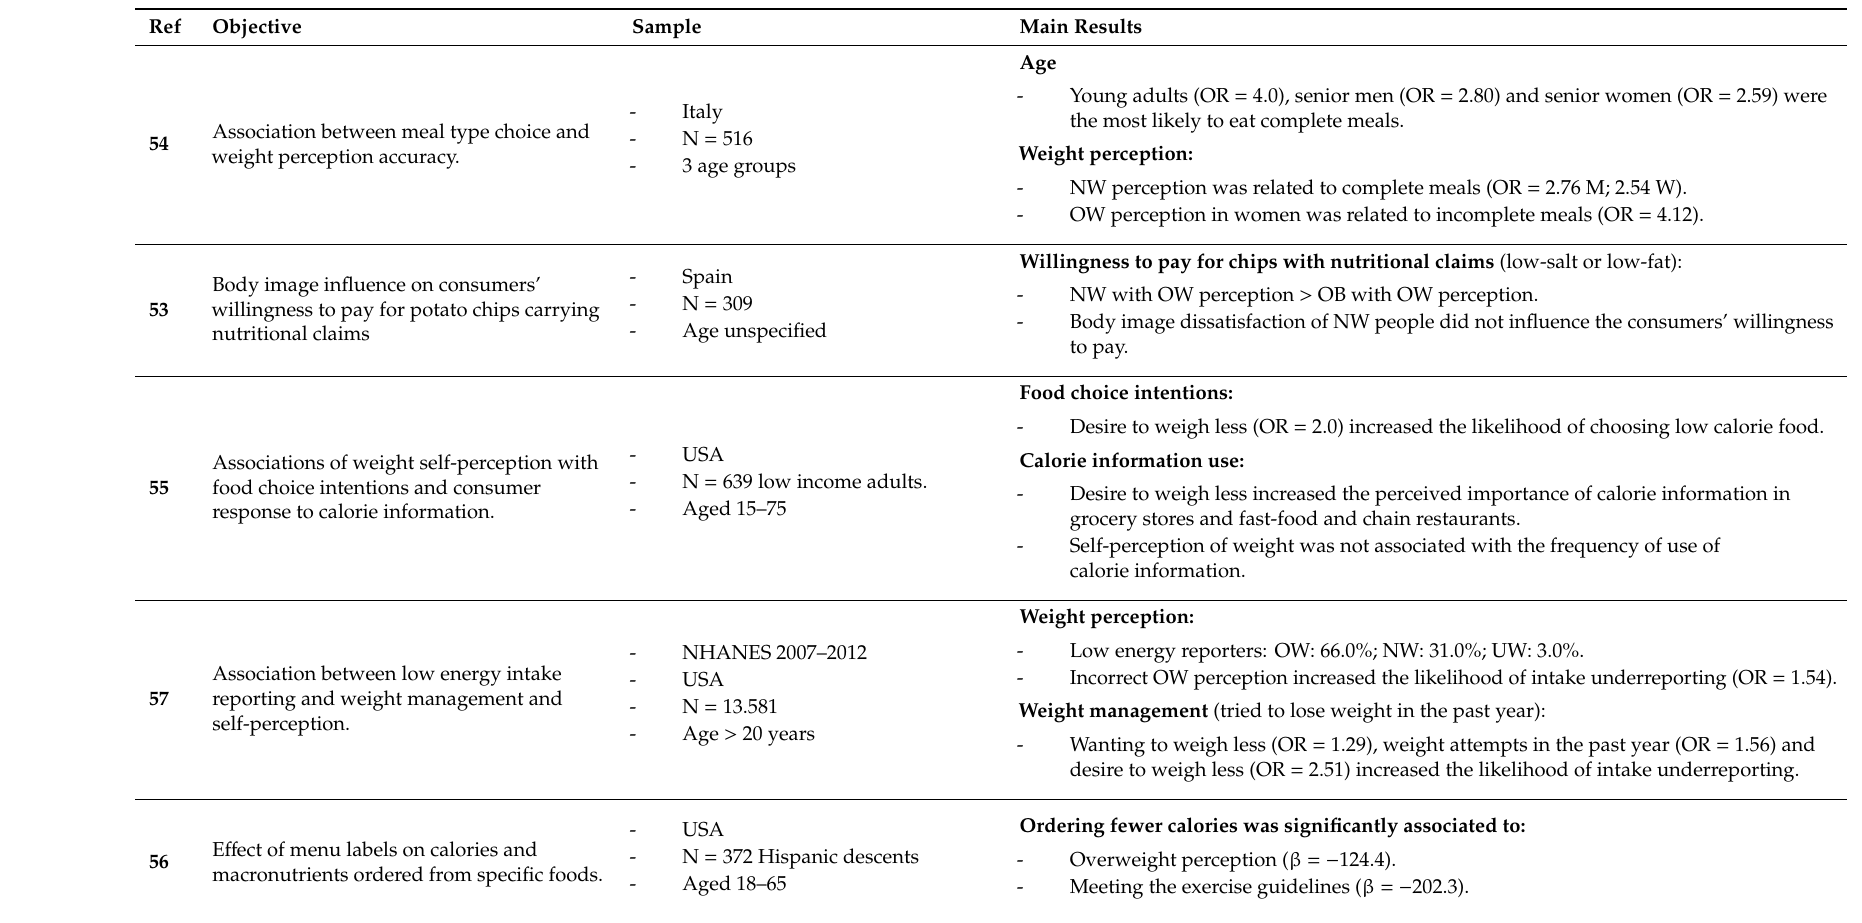
Table 1. Observational